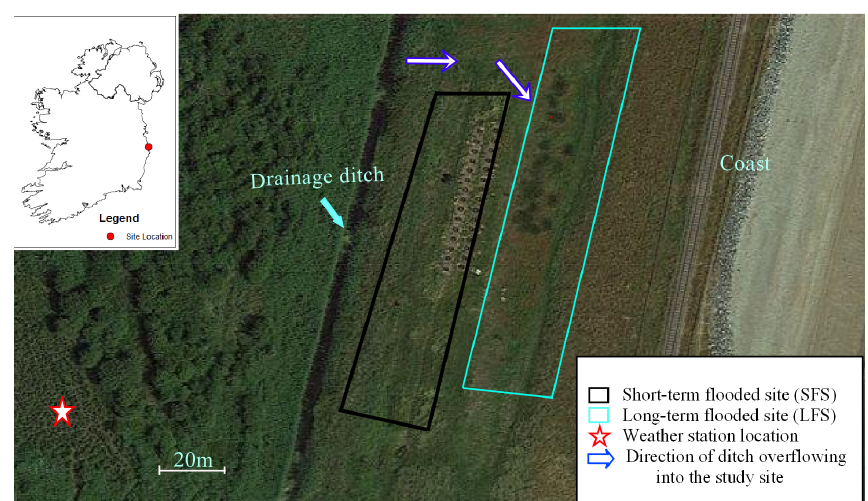
Figure 1. Aerial photograph of part of East Coast Nature Reserve at Blackditch Wood, County Wicklow, showing the study sites and the direction in which water flows during flooding. Inset shows map of Ireland with site location